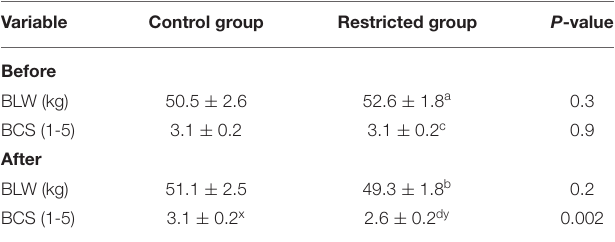
TABLE 2 | Values (Mean ± SEM) of body live weight (BLW) and body condition score (BCS) of alpacas fed 40% of maintenance energy requirements (restricted group; n = 7) or fed ad libitum (control group; n = 7) before and after the nutrition management for 21